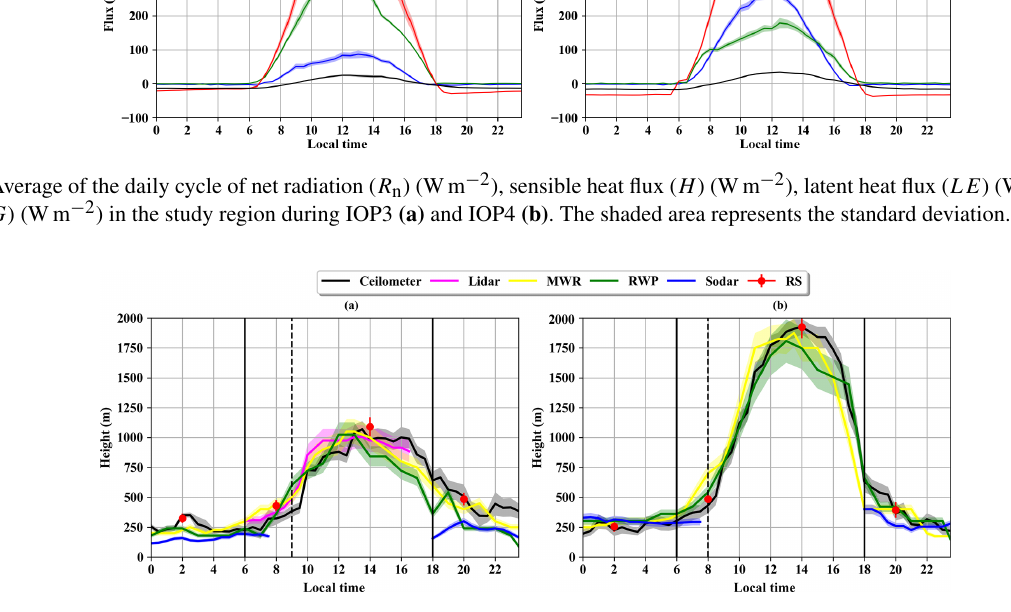
Figure 6. Daily cycle of the height of the PBL during the IOP3 (a) and IOP4 (b) experimental periods. The vertical lines represent sunrise (06:00LT), sunset (18:00LT) (full line) and NBL erosion (dashed line). The shaded area represents the standard